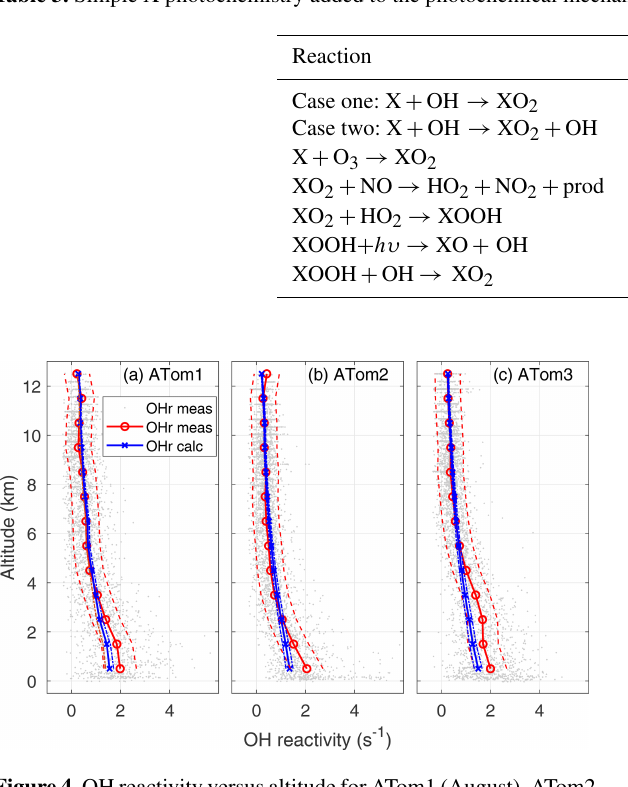
Table 3. Simple X photochemistry added to the photochemical mechanism to test for effects of X on modeled OH and HO 2 .